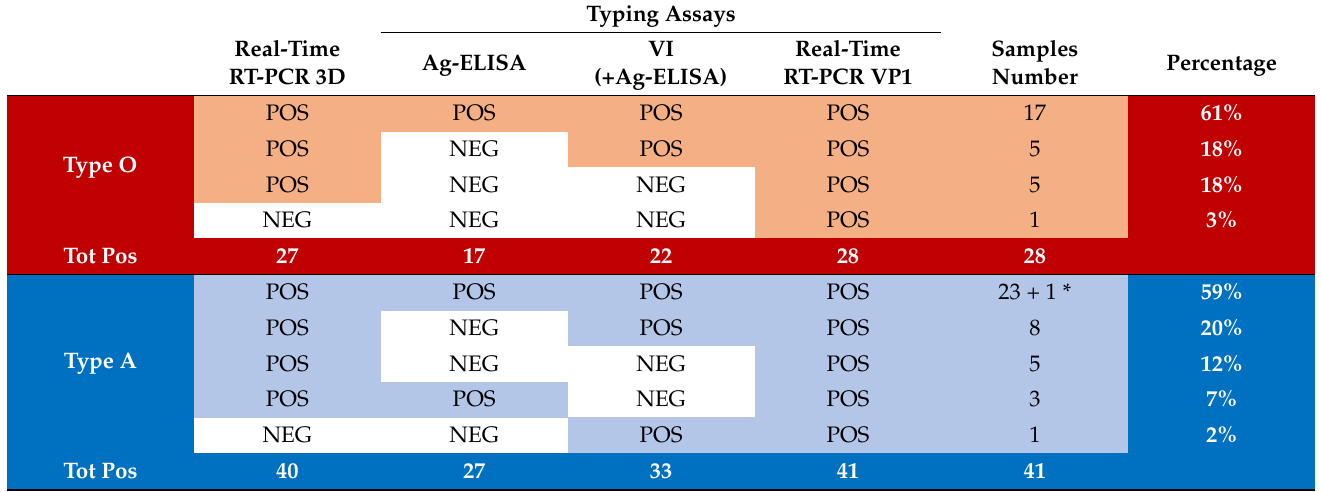
Table 1. Summary of the results obtained using four assays examined in this study. A real-time RT-PCR targeted on 3D sequence for pan-FMDV detection (real-time RT-PCR 3D); the monoclonal antibodies-based FMDV antigen detection and serotyping ELISA kit (Ag-ELISA); virus isolation on LFBK α V β 6 cell line combined with the above Ag-ELISA kit (VI+Ag- ELISA); and a panel of four real-time RT-PCRs tailored for the topotypes circulating in the East Africa region (real-time RT-PCR VP1). Colours refer to the four serotypes following the scheme proposed by the World Reference Laboratory for Foot-and-Mouth Disease: in red type O, in blue type A, in yellow type SAT1, and in purple type SAT2. *, samples from which two serotypes were detected contemporarily using the topotype-specific real-time RT-PCRs.3.2. Detection and Serotyping